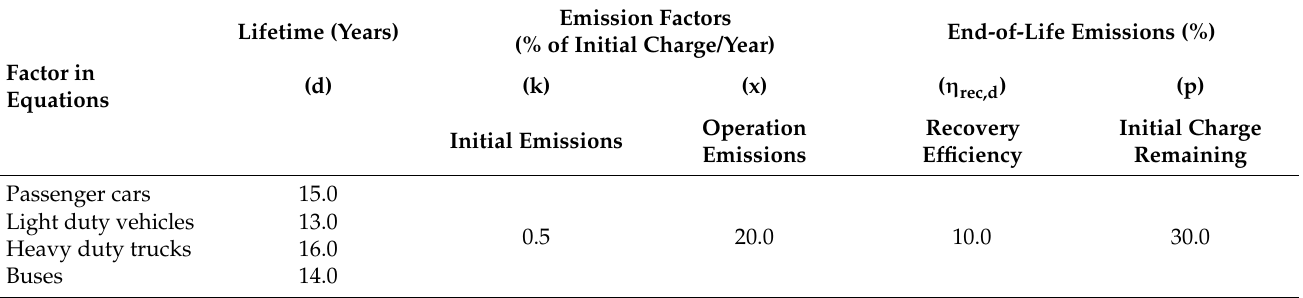
Table 6. EFs used for calculation of MAC emissions